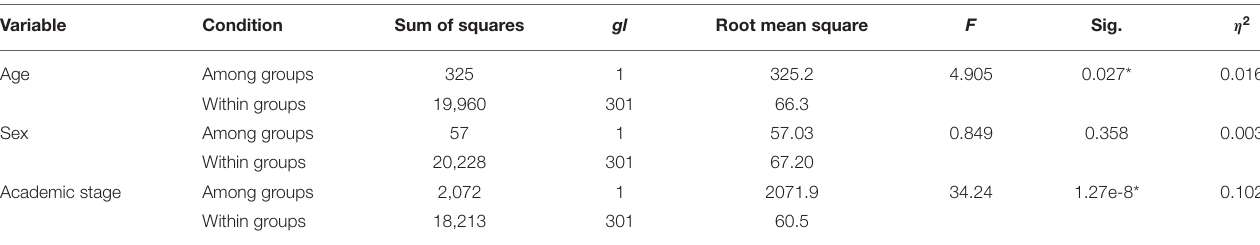
TABLE 5 | ANOVA test of mean differences among age , sex , and academic stage groups.